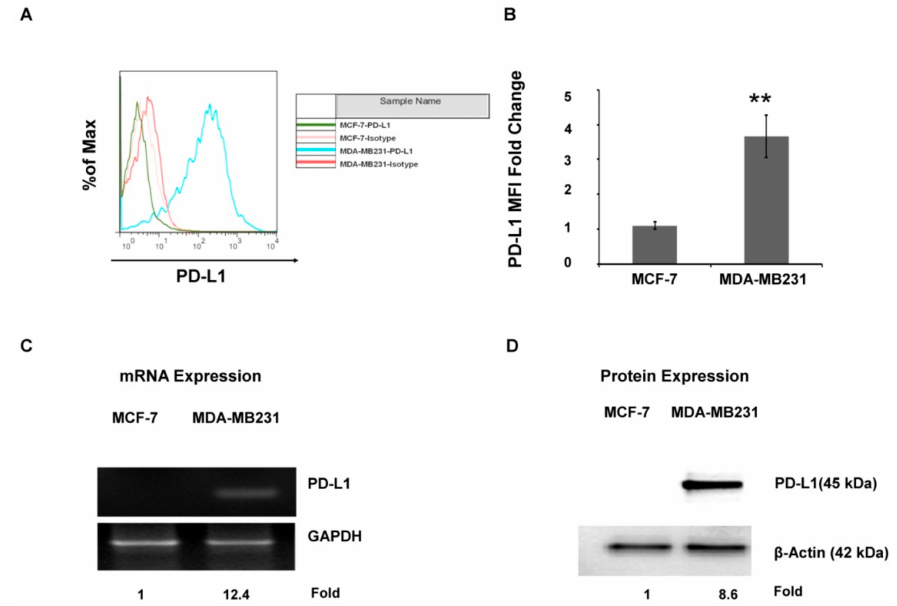
Figure 1. Programmed death ligand 1 (PD-L1) expression status of breast cancer cells: ( A ) Cell surface PD-L1 and ( B ) an average of the fold change of median fluorescence intensity (MFI). ( C ) PD-L1 mRNA expression and ( D ) PD-L1 protein expression. Each value is the mean ± SD of three independent experiments. Statistical significance ** p <